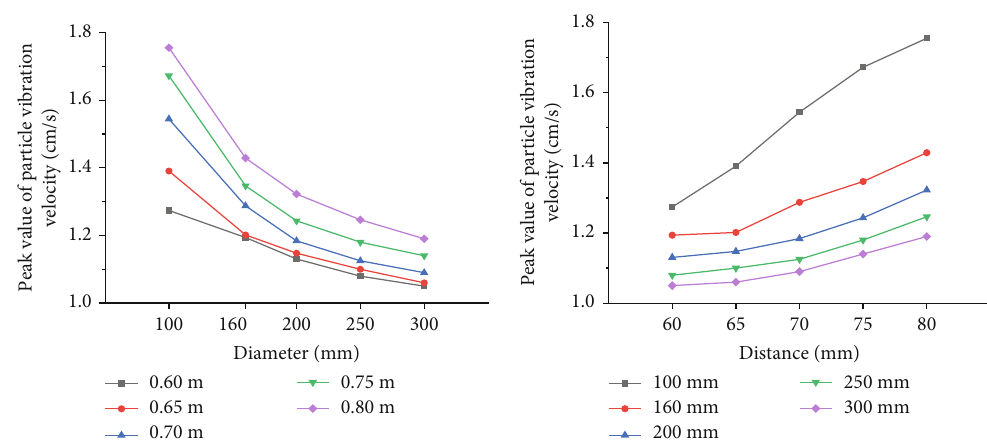
Figure 24: The in fl uence of diameter and distance on the peak value of particle vibration